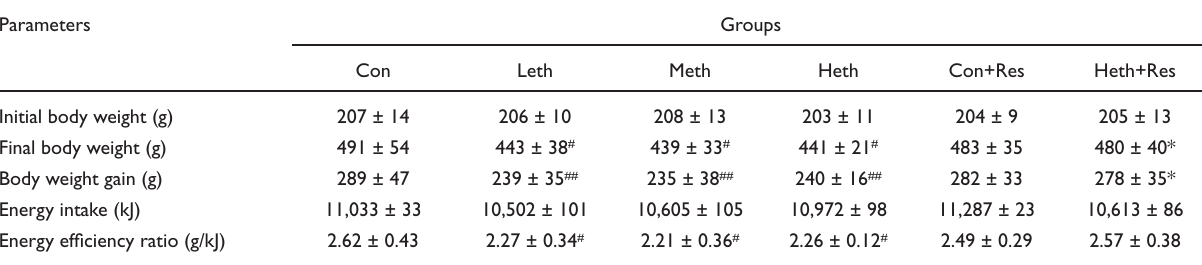
Table 1. Growth parameters in rats after chronic ethanol intake with or without Resveratrol supplemented Parameters